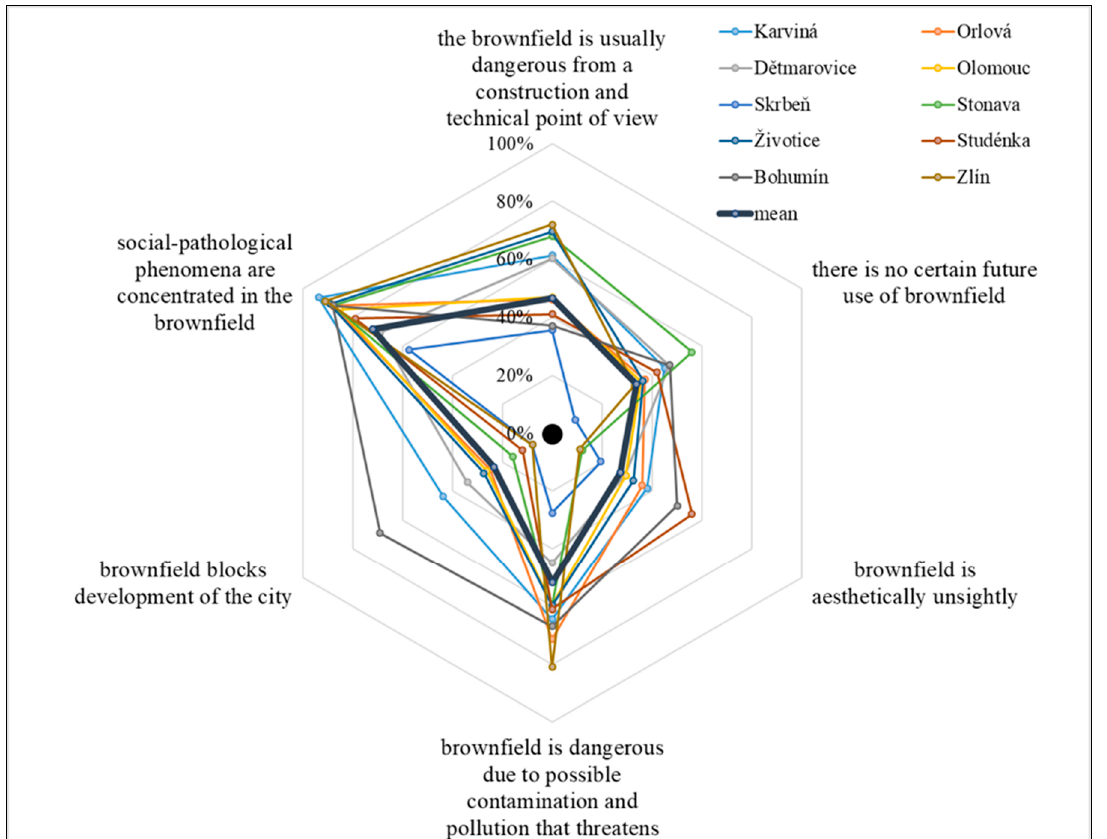
Figure 4. Reasons why brownfields have a significant influence on the property values. Source: own survey (n = 1,152).